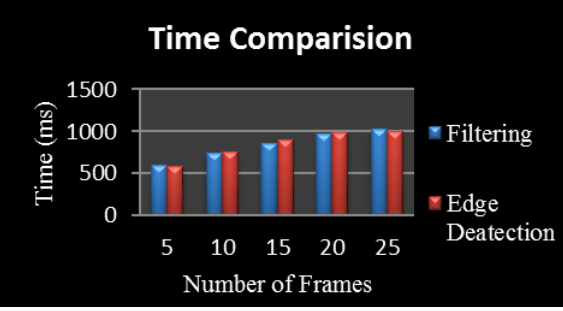
Figure 2. Time comparison for filtering and edge detection process